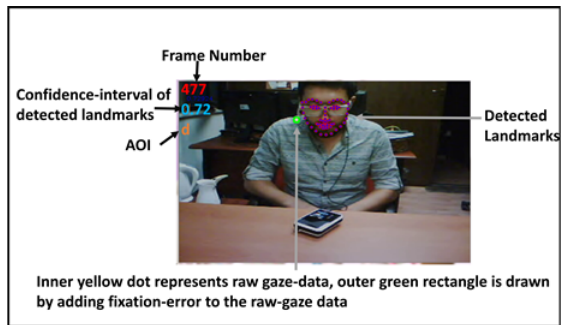
Figure 4 . A snapshot from the visualize-tracking panel.